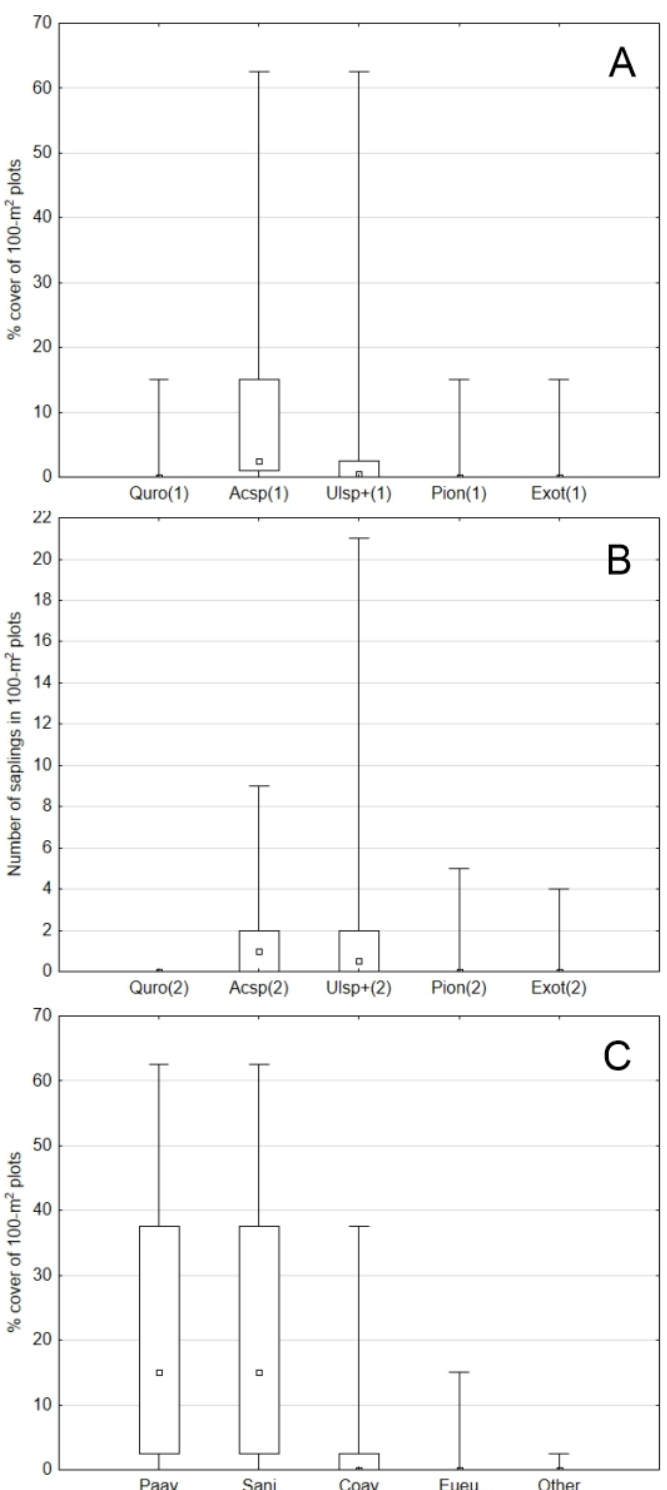
Figure 7. Undergrowth abundance (medians–interquartile range–min–max) in 108 plots (stratified random sampling); ( A ): seedlings and short saplings ( ≤ 0.5 m), ( B ): taller saplings (>0.5–5 m), ( C ):